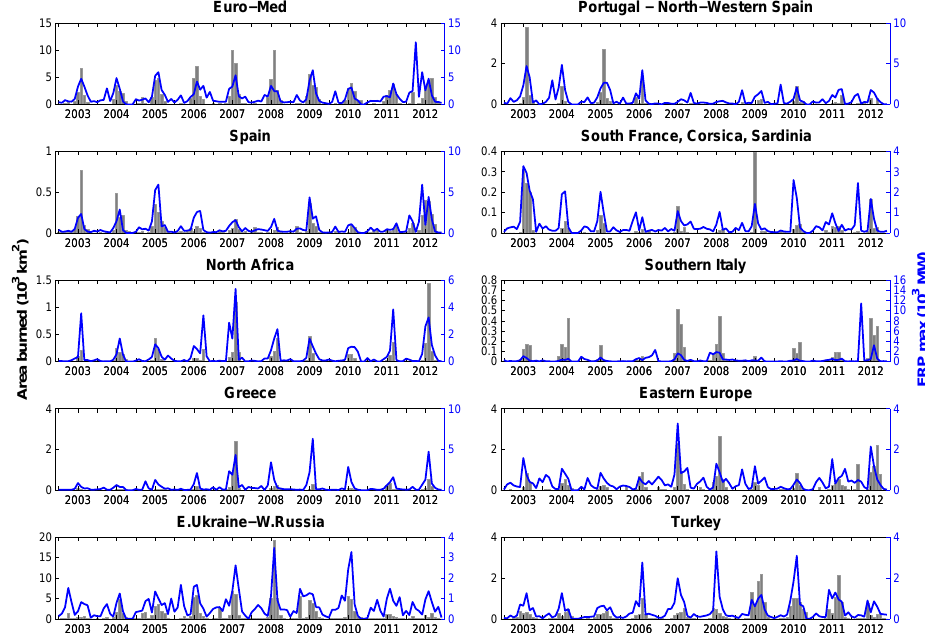
Fig. 4. Monthly burned area (bar plot) according to the MODIS MCD64 product (500m resolution) for the 2003–2012 time period and within the main burning subregions. The corresponding maximum FRP detected is also plotted (solid line). Ticks on the x axis correspond to January and July.